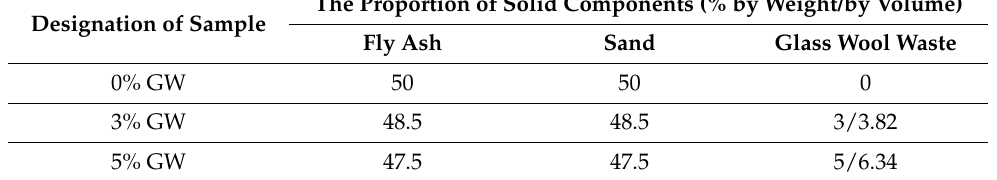
Table 2. Determination of samples, weight and volume fractions of fillers. Designation of